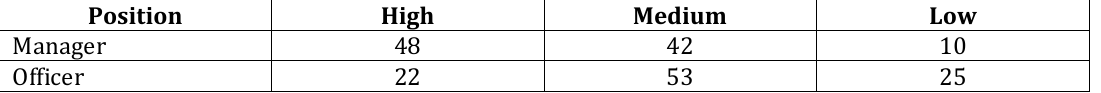
Table 7: Distribution of Managers and Officers according to their Compliance Level